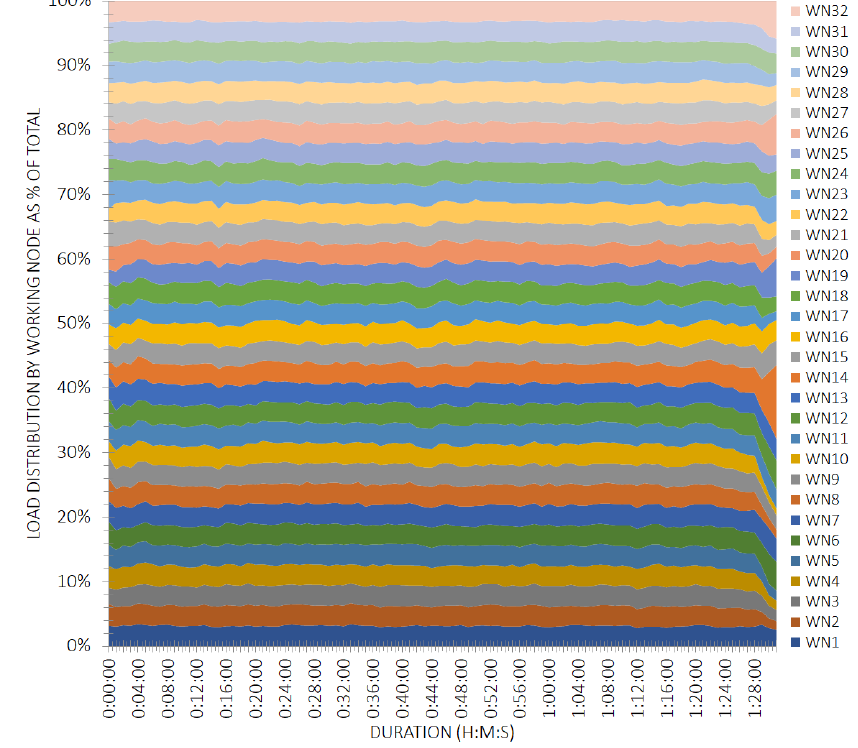
Figure 8. Load distribution between worker nodes during the execution of the large-scale experiment (32 worker nodes, equivalent to 512 cores, and 2048 GB of RAM). It is observed how throughout the experiment the load was balanced evenly between the job nodes, optimally exploiting the computing capabilities of the cluster ( ∼ 4000 jobs running